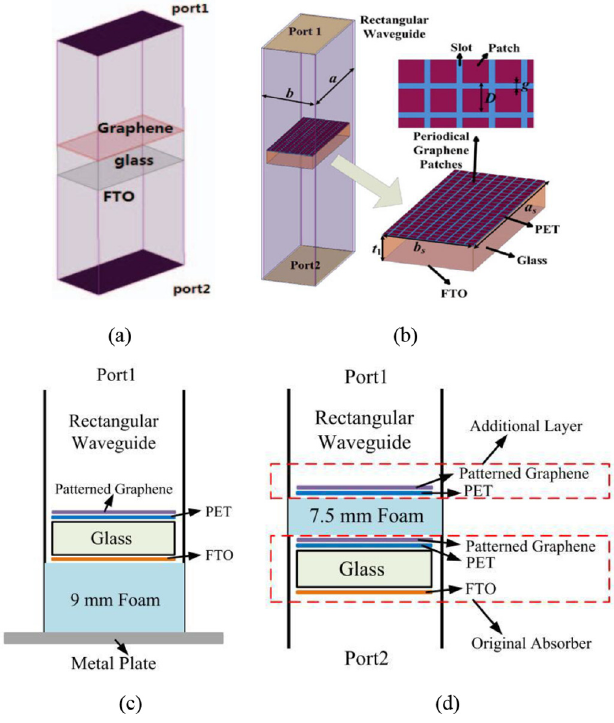
Fig. 4. (a) The con fi guration of the absorber based on graphene. (b) The con fi guration of the absorber based on patterned graphene. (c) The con fi guration of the absorber based on patterned graphene with metal plate. (d) The con fi guration of the absorber with double-layer patterned